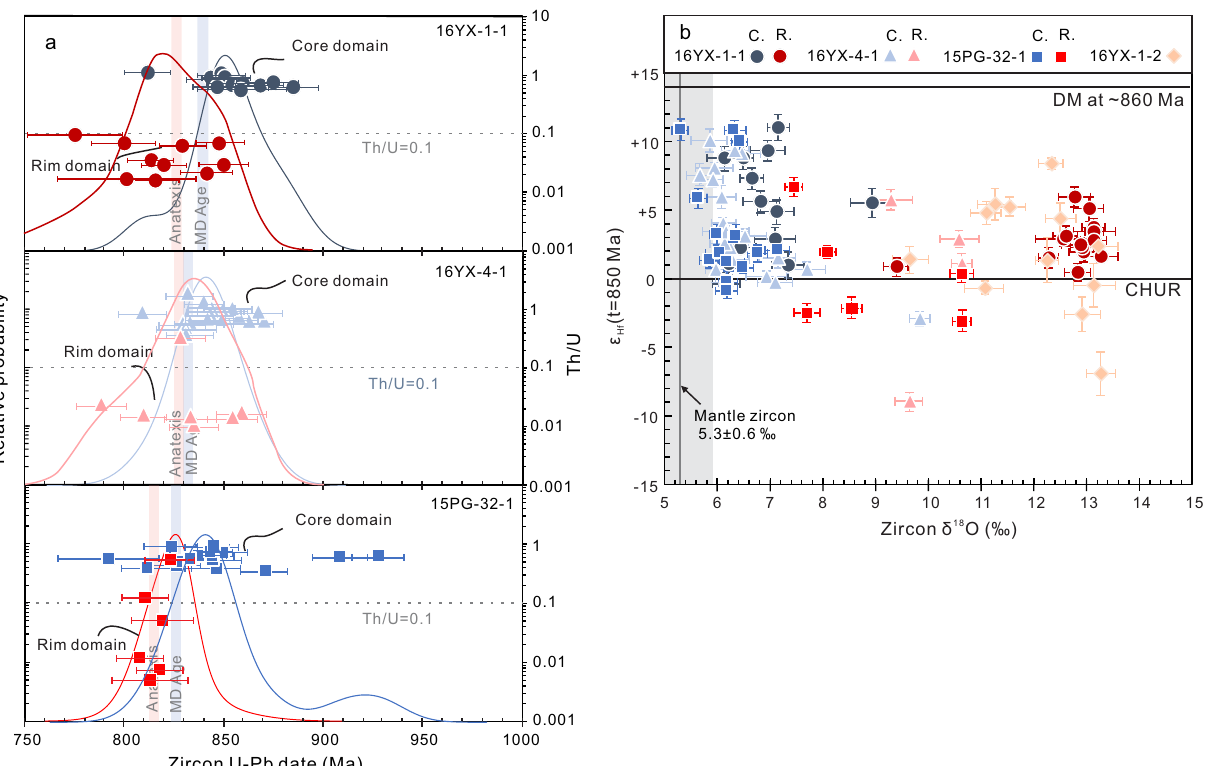
Fig. 1 Zircon U − Pb age distributions and zircon δ 18 O- ε Hf (t) values of the Pengguan migmatites. a Core and rim age distribution of zircon grains extracted from Pengguan migmatites. Unimodal core and rim zircon U-Pb dates distribution is shown in the diagram. Anatexis and maximum depositional ages (MD Age, see discussion for the calculation) of each sample are marked with light red and blue, respectively. Zircon U − Pb dates with concordant U − Th − Pb isotopes were used here. Error bars are shown at one standard error. The concordant criteria were adopted from Spencer et al. 40 . b δ 18 O- ε 850 Ma) diagram for zircon core and rim domains of three migmatite samples and zircon grains from leucosome. Error bars are shown at one standard error for δ 18 O value and two standard errors for ε Hf ( t ) value. C = core domain, R = rim domain. Mantle zircon δ 18 O = 5.3 ± 0.6 ‰ (ref. 41